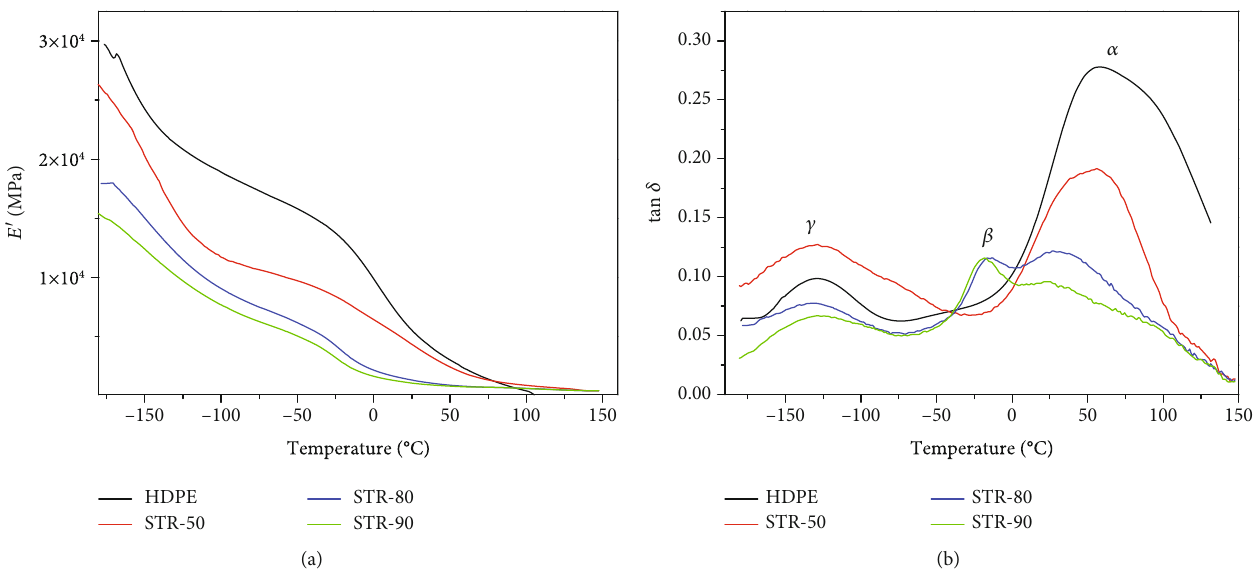
Figure 5: Starch-based composite fi bers (a) E ′ and (b) tan δ vs. temperature.